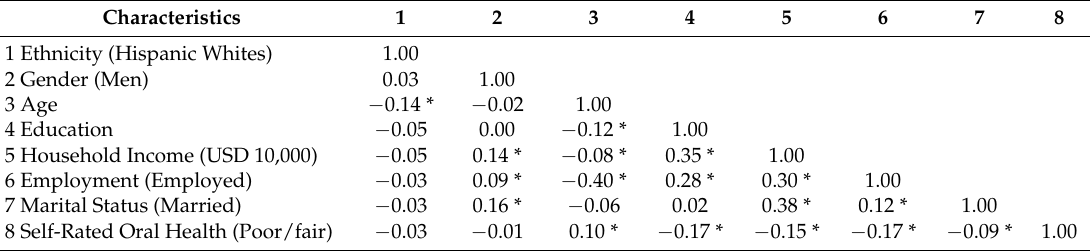
Table 2. Spearman correlations in the pooled sample.